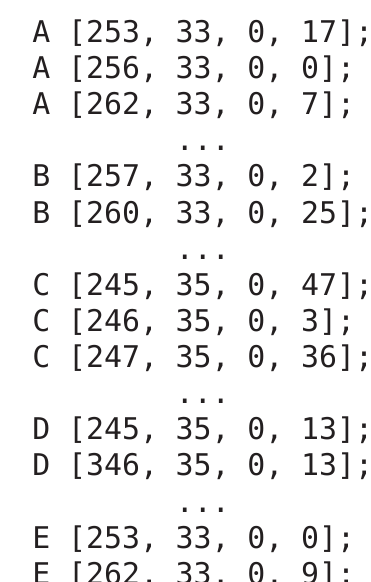
... Figure 2: Example of an input file for the Redi